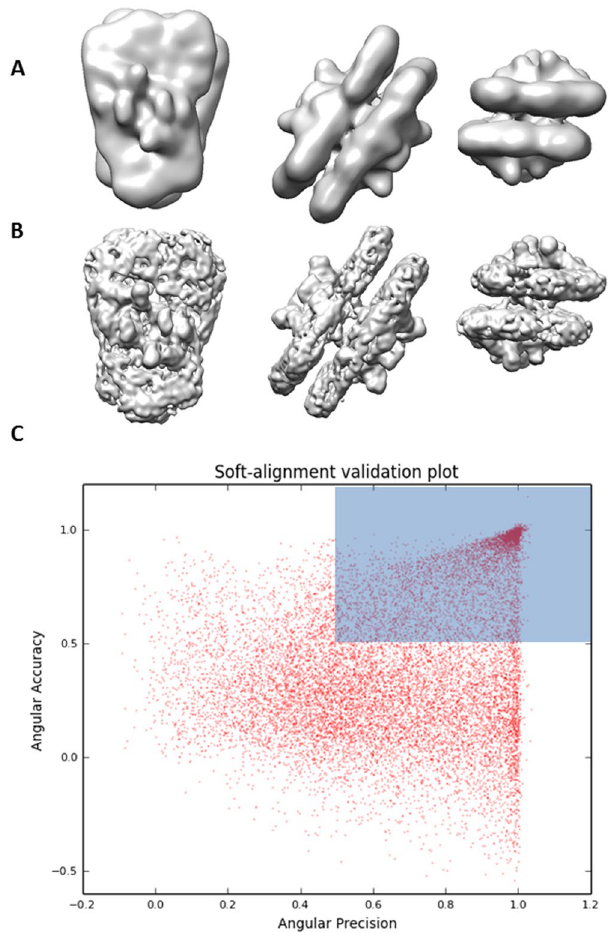
Figure 13. Views at different orientations of the map without ( A ) and with ( B ) pruning process and respective soft-alignment validation plot ( C